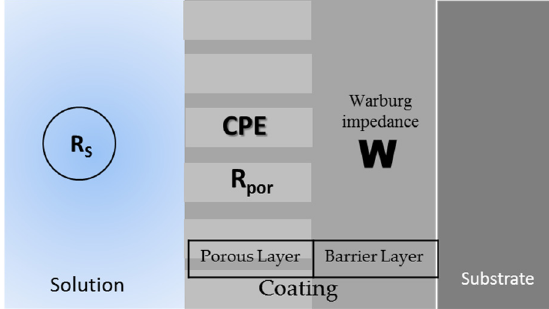
Figure 9. Corrosion system of the anodized samples.